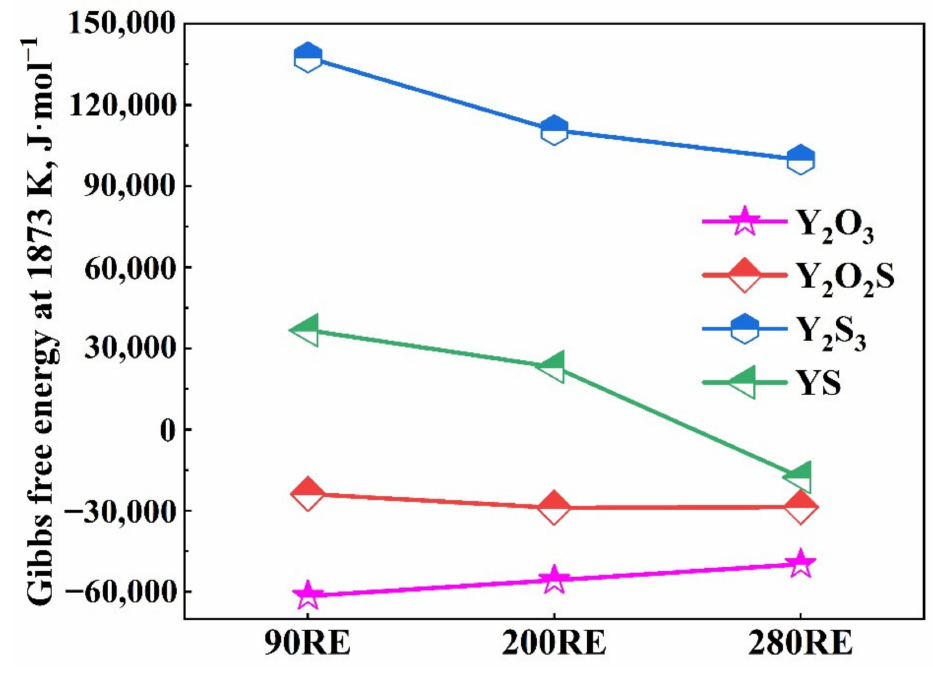
Figure 6. Experimental steels inclusions Gibbs free energy at 1873K. Table 2. First-order interaction coefficients e j